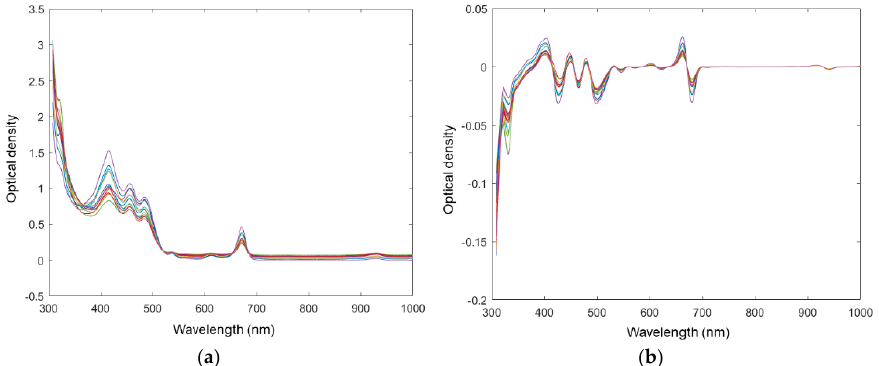
Figure 3. ( a ) Multiplicated scatter corrected and ( b ) multiplicative scatter correction followed by the first-level derivative (MSC-Der1) pretreated microtiter plate reader spectra.